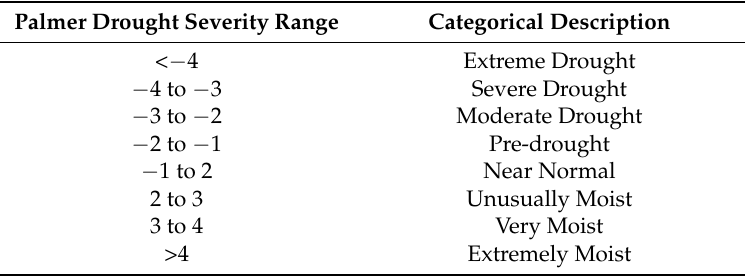
Table 2. Palmer Drought Severity Index scale and